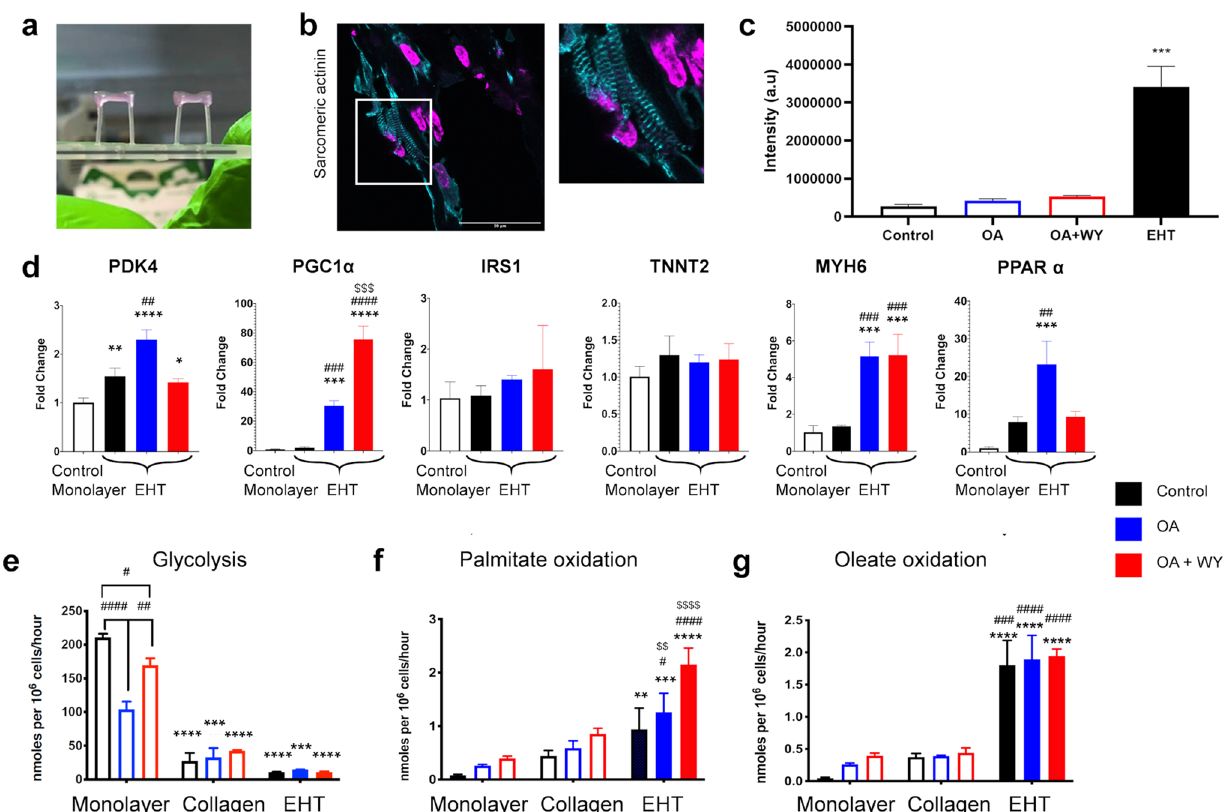
Figure 5. ( a ) EHT attached to the silicon posts; ( b ) immunostaining for α-Sarcomeric Actinin (Actinin-cyan, DAPI-magenta) in a section through an EHT, scale bar is 50 µm with × 2 zoom to the right; signal intensity is quantified in ( c ) compared with that for cells in 2D shown in Fig. 1b, indicated as open bars. ( d ) Changes in mRNA expression in day 15 hiPSC-CMs seeded as a monolayer on RF-Matrigel or in EHTs and treated with OA ± WY-14643 for 1 week. Rates of ( e ) glycolysis and oxidation of ( f ) palmitate and ( g ) oleate in EHT treated with OA ± WY-14643 for 1 week and compared with data for cells cultured in 2D or on 100% collagen scaffold, shown in Fig. 4, indicated as open bars. *, **, *** p < 0.5, 0.01, 0.001, respectively compared with hiPSC-CMs on RF-Matrigel; #, ##, ###, #### p < 0.5, 0.01, 0.001, 0.001, respectively compared to the control in their respective group; $$, $$$, $$$$ p < 0.01, 0.001, 0.001 compared to OA-treated EHTs for ( d ) or hiPSC-CMs on 100% collagen for ( e – g ). Data in ( c – d ) were compared using a one way ANOVA and in ( e – g ) were compared